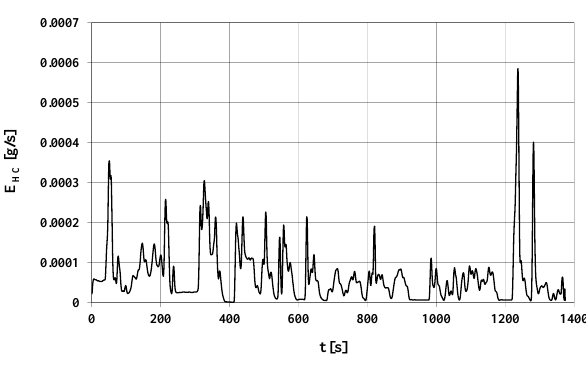
Fig. 8. The process of hydrocarbons emission intensity in the Malta test